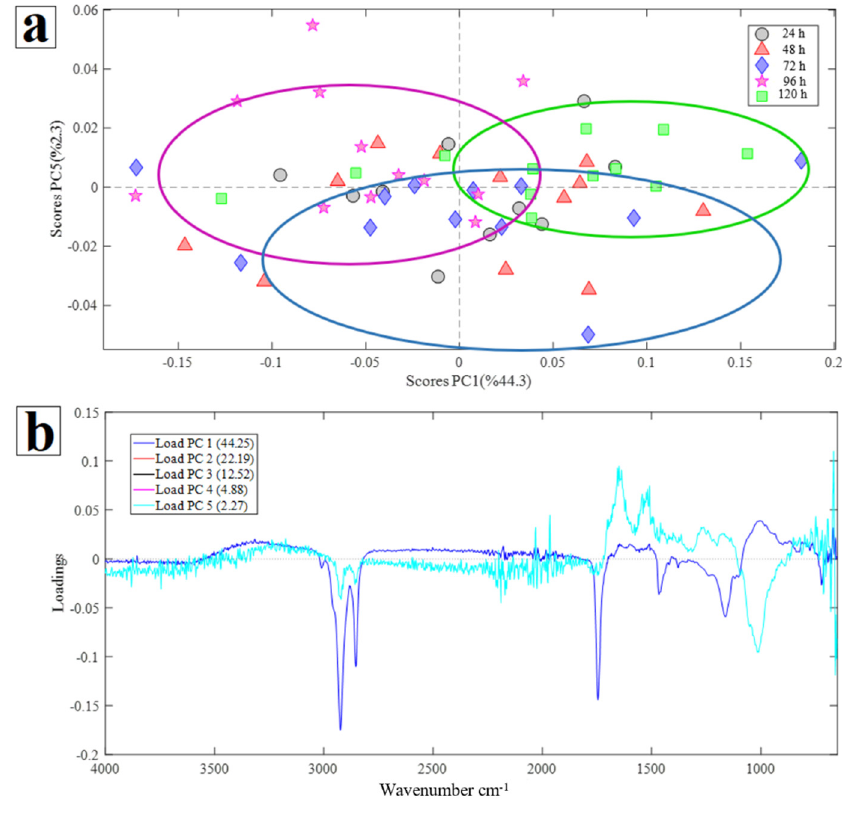
Figure 5. General PCA classified by fermentation time ( a ), loading graph highlighting the first and fifth main component (PC1 and PC5) ( b ).